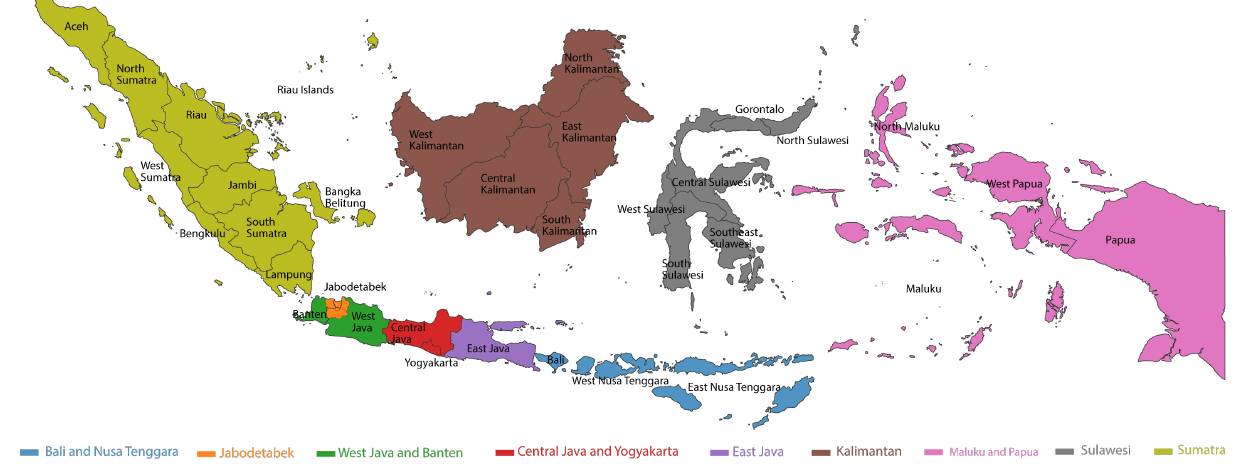
Figure 3. Map of Indonesia divided into nine different regional